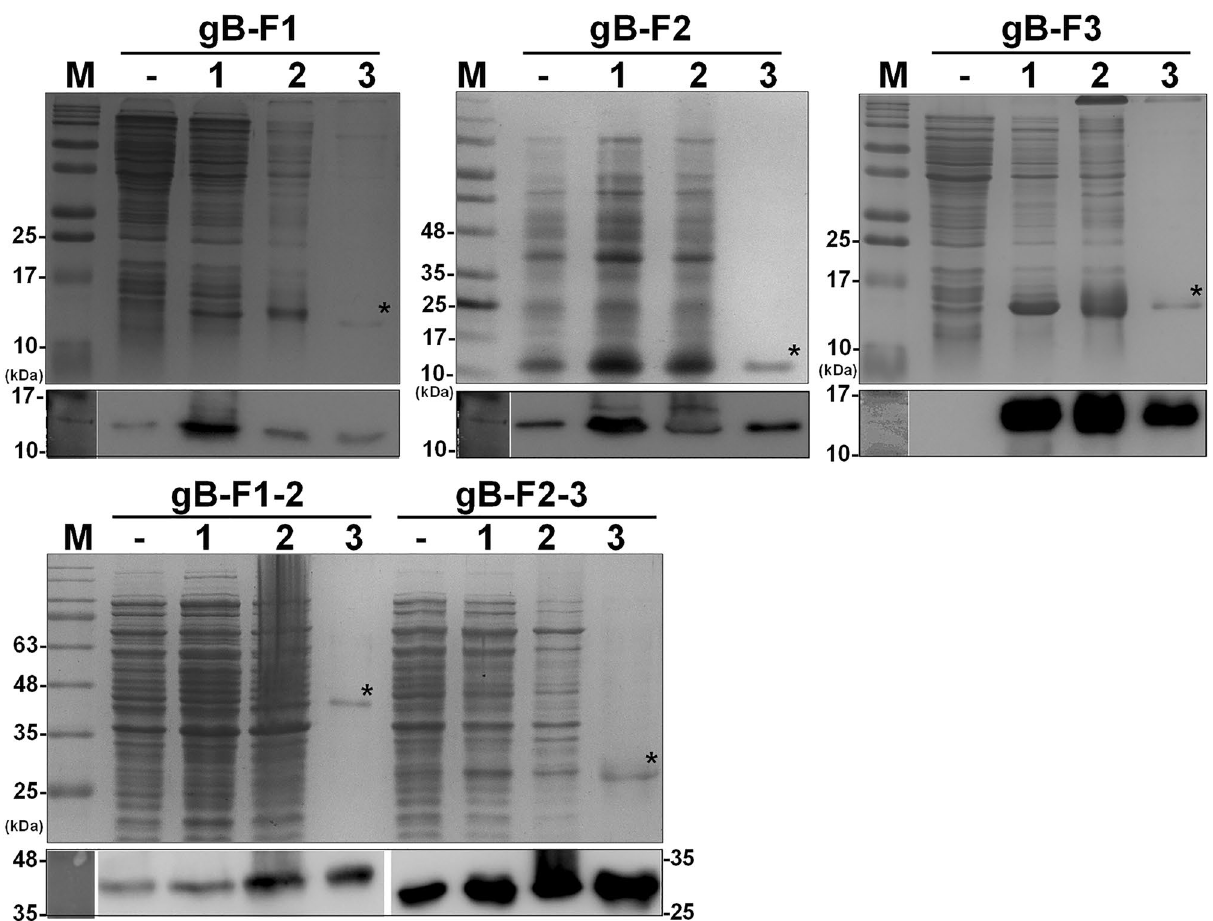
Figure 1. Generation of recombinant partial gB proteins. Five antigenic fragments of gB protein, labeled gB-F1, gB-F2, gB-F3, gB-F1–2 and gB-F2–3, were expressed in E. coli under IPTG treatment (Lanes 1, 2, 3) and purified by Ni–NTA affinity chromatography. Purified proteins (Lane 3) with the expected molecular weight are indicated as asterisks. Five gB fragments were expressed as a fusion protein with a six-histine tag at its C-terminus, which was confirmed by western blot analysis with an anti-histidine antibody (shown in the panel below SDS-PAGE). Line—indicates the mock control lysate without IPTG induction, and Lanes 1 and 2 are the total and insoluble fractions of bacterial lysate, respectively. (For gB-F1, gB-F2 and gB-F3, not the whole blot was used to react with antibody. Due to the molecular weights of target proteins gB-F1, gB-F2 and gB-F3 are very small (around 10 kDa), the protein-transferred membrane was trimmed to the region between 15 and 10 kDa below for further antibody